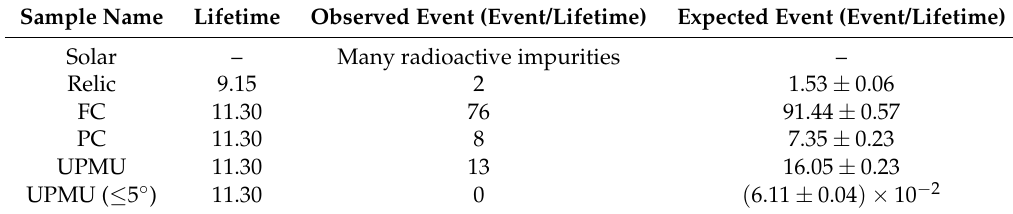
Table 5. Analysis results of the 14-day window search. Lifetime for each sample, the observed events within the lifetime, and the expected background event within the lifetime are described. As mentioned in the main text, we did not carry out the search in the solar sample due to the large amount of background due to radioactive impurities.